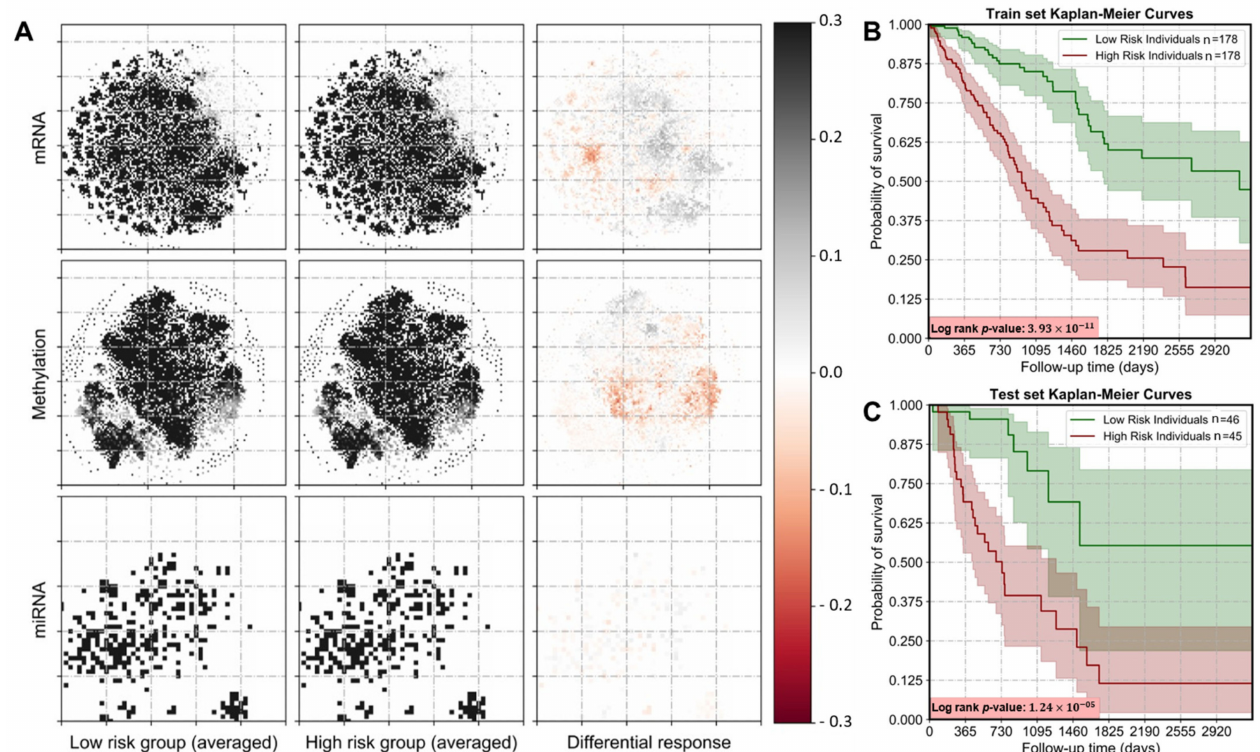
Figure 3. Differential analysis and survival classes. ( A ) Image representations for all the omics types for the two patient risk groups depicting the differential genes (marked with colors). Kaplan–Meier plots for ( B ) train and ( C ) test sets showing that SurvCNN can segregate patients into two risk groups with a high degree of confidence (log-rank p